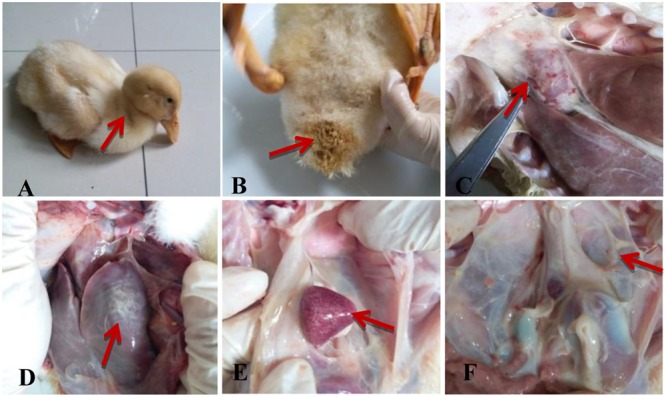
Clinical symptoms and necropsy lesions of the APEC-infected ducks. (A) Listlessness and anorexia; (B) Diarrhea; (C) Heart surface had a layer of yellowish–white fibrinous exudate; (D) Fibrinous exudate in the liver surface; (E) Splenomegaly and hemorrhage; (F) Peritoneal fibrosis adhesions.